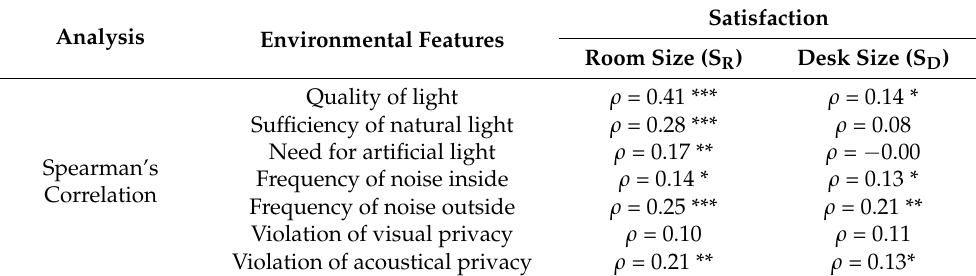
Table 6. Relationships between lighting, noise, and privacy and satisfaction with home workspace size. Satisfaction Analysis Environmental Features Room Size (S R ) Desk Size (S D ) Quality of light Sufficiency of natural Spearman’s Correlation